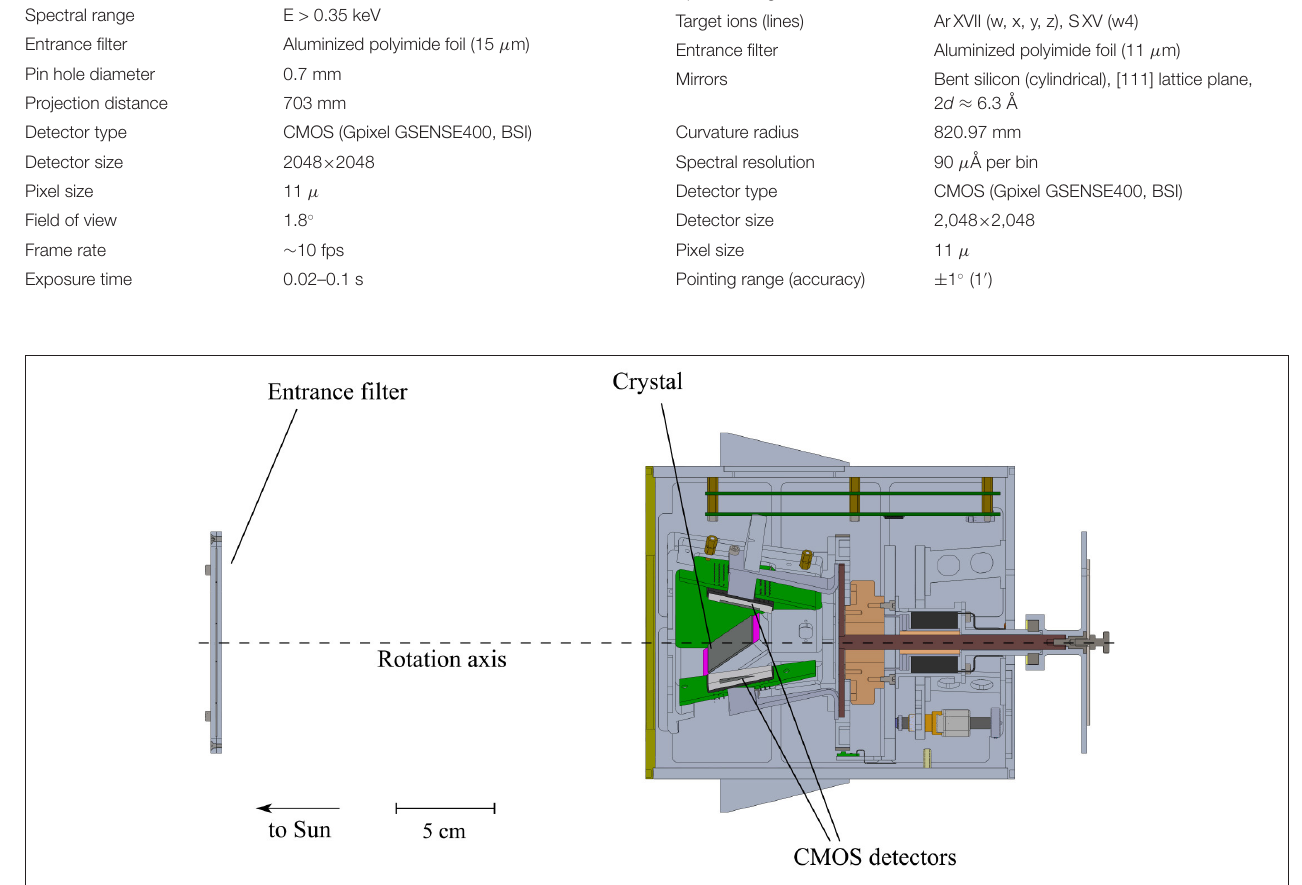
FIGURE 7 | A cross sectional view of the Bragg X-ray spectrometer–polarimeter (B-POL) inside the KORTES-SU assembly. The table with two silicon crystals (mounted at Brewster angle) and two CMOS sensors is spinning around an axis pointing to a solar X-ray source at 1 turn per second.